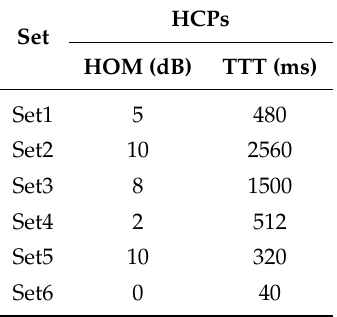
Table 4. Fixed HOM and TTT.